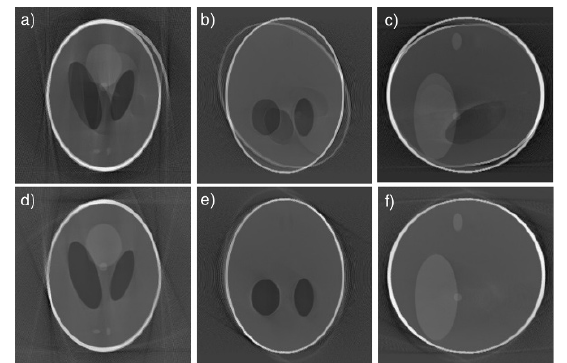
Figure 19. (a–c) axial, coronal and sagittal slices of the rotational motion corrupted case; (d–f) same slices after motion compensation.